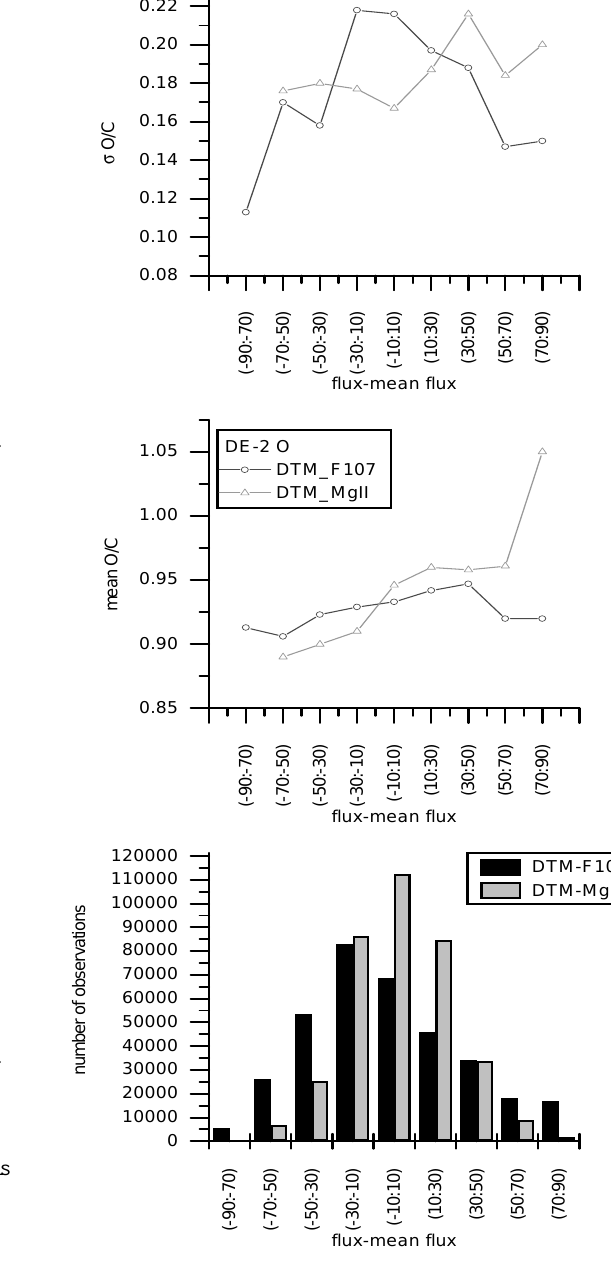
Fig. 6. The mean and scatter of the DE-2 oxygen residuals pre- sented in F10 . 7 − F10 . 7 bins, where F10 . 7 represents the 27-day mean of the solar radio flux or the rescaled Mg II index. The his- togram at the bottom displays the distribution of F10 . 7 − F10 . 7 at the observation